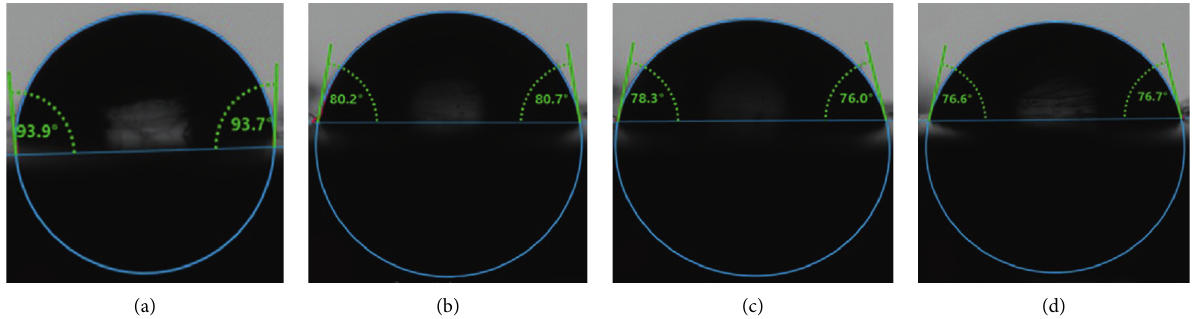
Figure 4: Contact angle measurements of tested specimen surfaces based on different ZrO resin. (a) Control; (b) 1% ZrO 2 NPs; (c) 2.5% ZrO 2 NPs; (d) 5% ZrO 2